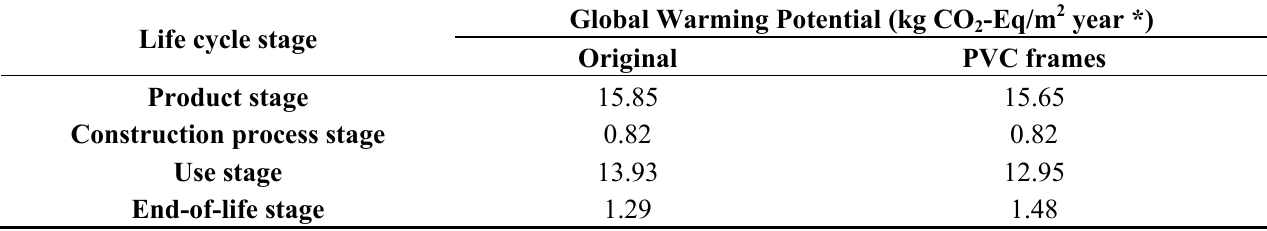
Table 9. Numerical comparison of the global warming potential impact (in kg CO -Eq/m 2 year) in the building analyzed according to the PVC frames improvement. 2